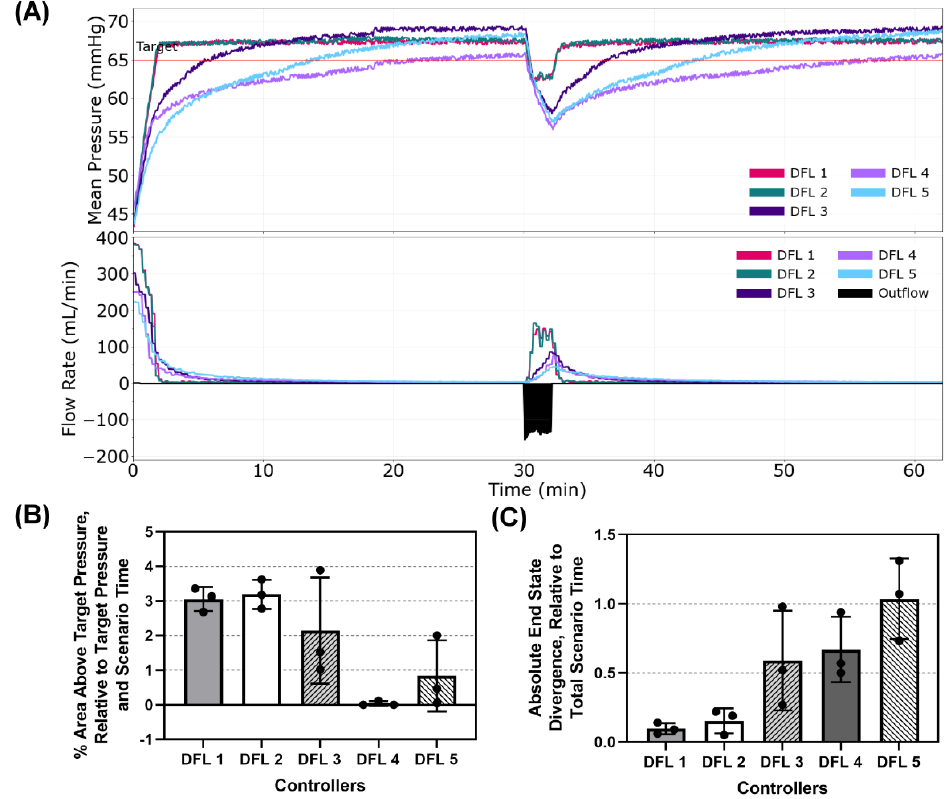
Figure 4. Dual-input fuzzy logic results for Scenario 1. Scenario 1 began with a MAP of 45 mmHg with no active hemorrhage for 30 min, followed by a fast hemorrhage for 2 min and then no hemorrhage for the remaining 30 min. ( A ) Five controller designs’ MAP and infusion rate vs. time are shown for one replicate run. A single representative outflow vs. time result is shown. ( B ) Area above target pressure and ( C ) Absolute end state divergence performance metrics for each controller design are shown as mean values from three subject variability runs, with error bars denoting standard deviation.